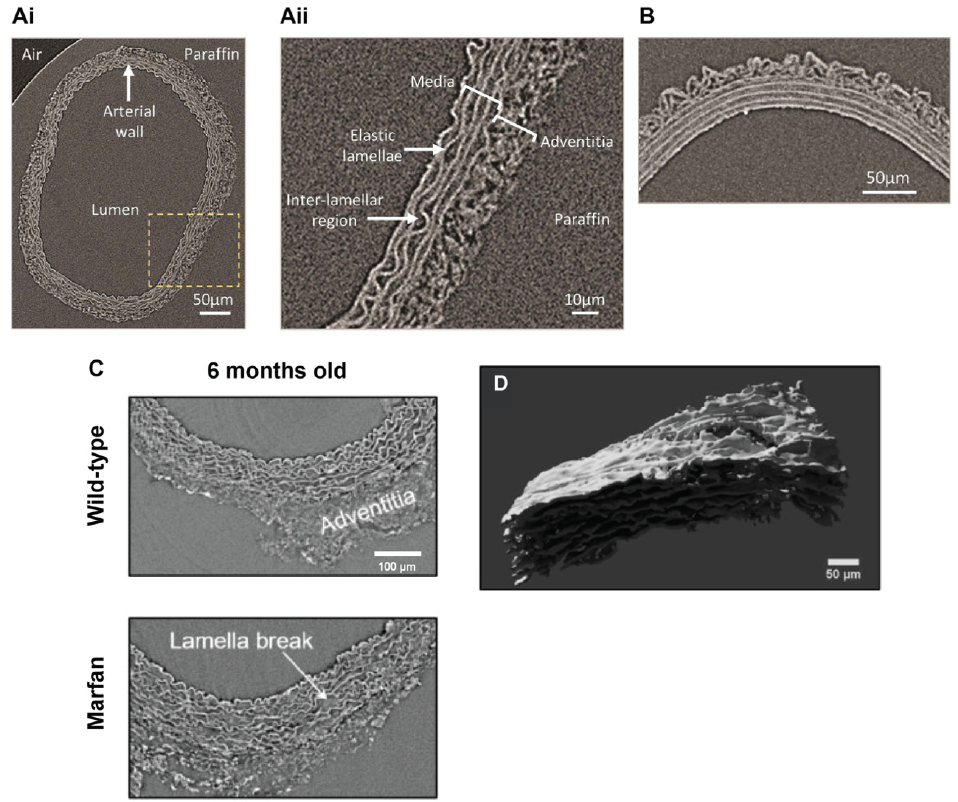
Figure 6. Visualization of elastic fiber remodeling in blood vessels. ( A )/( i ) Phase virtual slices from laboratory-based µCT of an intact rat common carotid artery at a 4x objective (voxel size 0.75 µm). The yellow box indicates the magnified region shown in ( A )/( ii ). ( B ) The resolutions achieved with laboratory-based µCT can be improved using a 20× objective (voxel size 0.5 µm). ( C ) Representative phase virtual slices from synchrotron-based µCT of intact aortas from 6 months old wild-type and Marfan syndrome mice. ( D ) 3-D volumetric rendering of a laterally-viewed aortic wall from a Marfan syndrome mouse; here, only lamellae of the tunica media layer are rendered. ( A )/( i,ii ), ( B ) Images reproduced from Reference [70]. ( C,D ) Images reproduced from Reference [91].